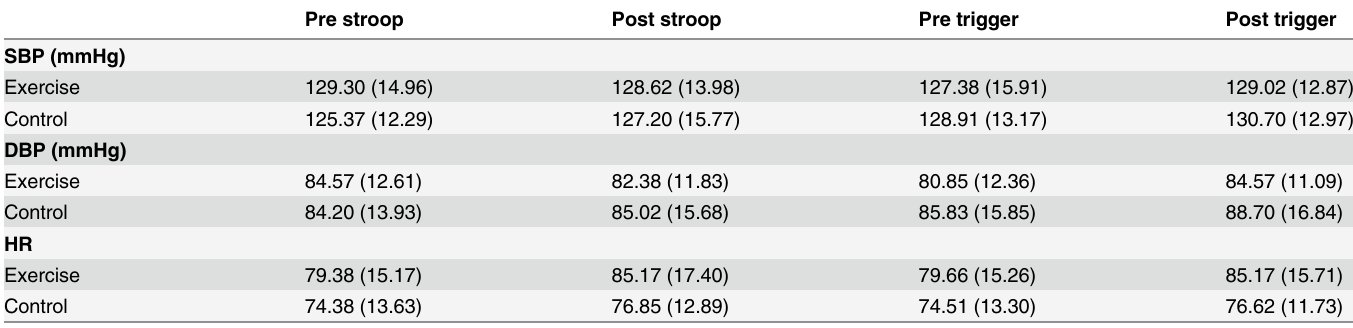
Table 2. Effect of exercise on systolic blood pressure (SBP), diastolic blood pressure (DBP) and heart rate (HR); reactions to a stress situation and a trigger, by condition over time. Pre stroop Post stroop